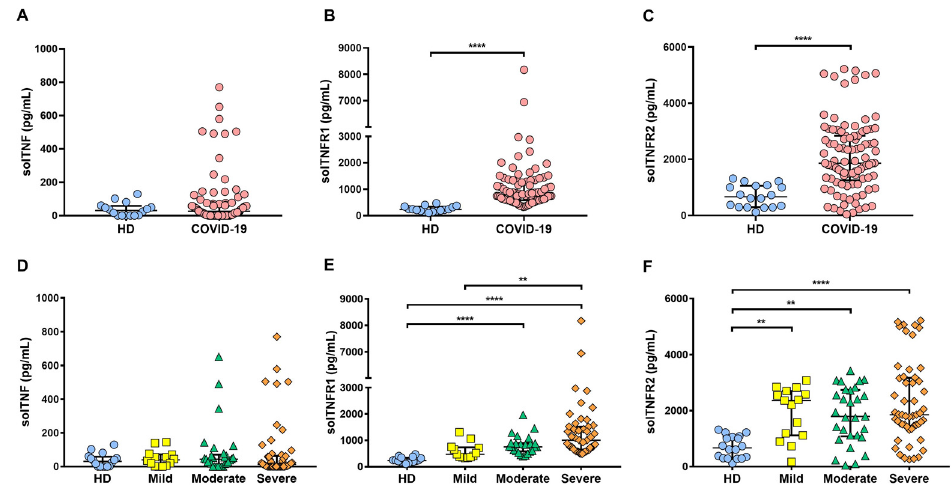
Figure 2. solTNFR1 and solTNFR2 are increased in COVID-19 patients. Soluble forms of TNF, TNFR1, and TNFR2 were quantified in the sera of COVID-19 patients and healthy donors (HD) by ELISA sandwich assay. A general comparison of solTNF, solTNFR1, and solTNFR2 levels between HD and COVID-19 was performed ( A – C , respectively). In addition, a more detailed analysis between HD and groups of COVID-19 (mild, moderate, and severe) was performed to confirm if solTNF, solTNFR1, and solTNFR2 levels were different ( D – F , respectively). Data are presented as median with interquartile range (solTNF: HD n = 16, mild n = 14, moderate n = 29, and severe n = 50; solTNFR1: HD n = 16, mild n = 13, moderate n = 24, and severe n = 49; solTNFR2: HD n = 18, mild n = 15, moderate n = 29, and severe n = 53), **** p < 0.0001, ** p < 0.01.